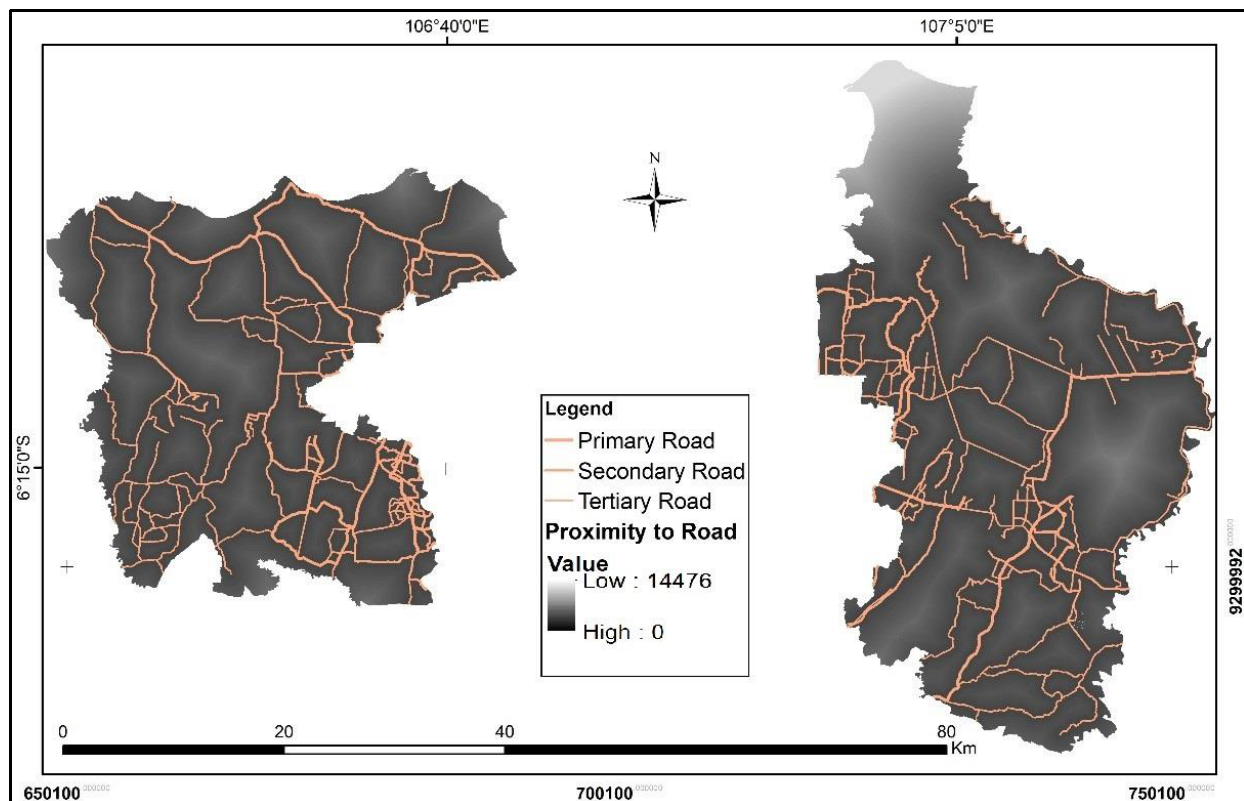
Figure 4. Example of the driven factor used in this study.